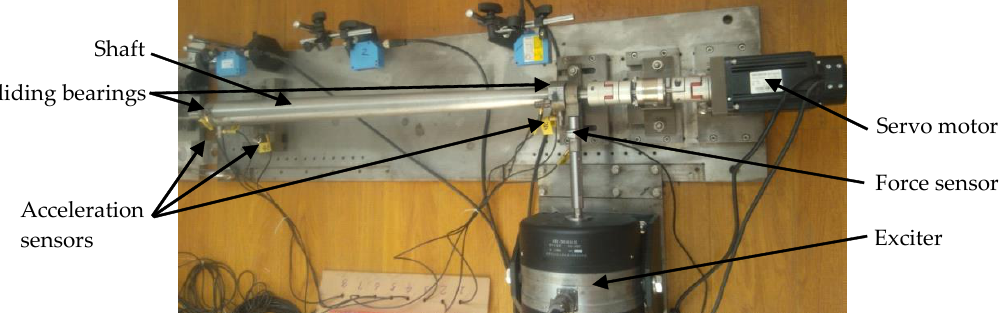
Figure 4. The rig built up for the experiments.